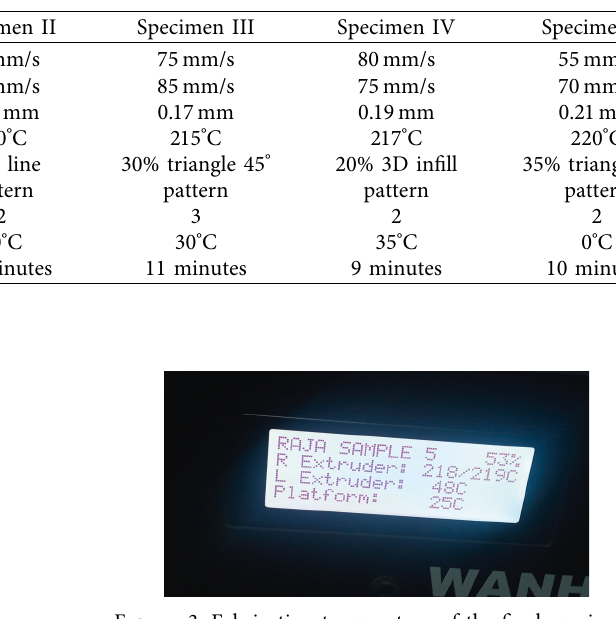
Table 1: Optimization parameters of specimens.